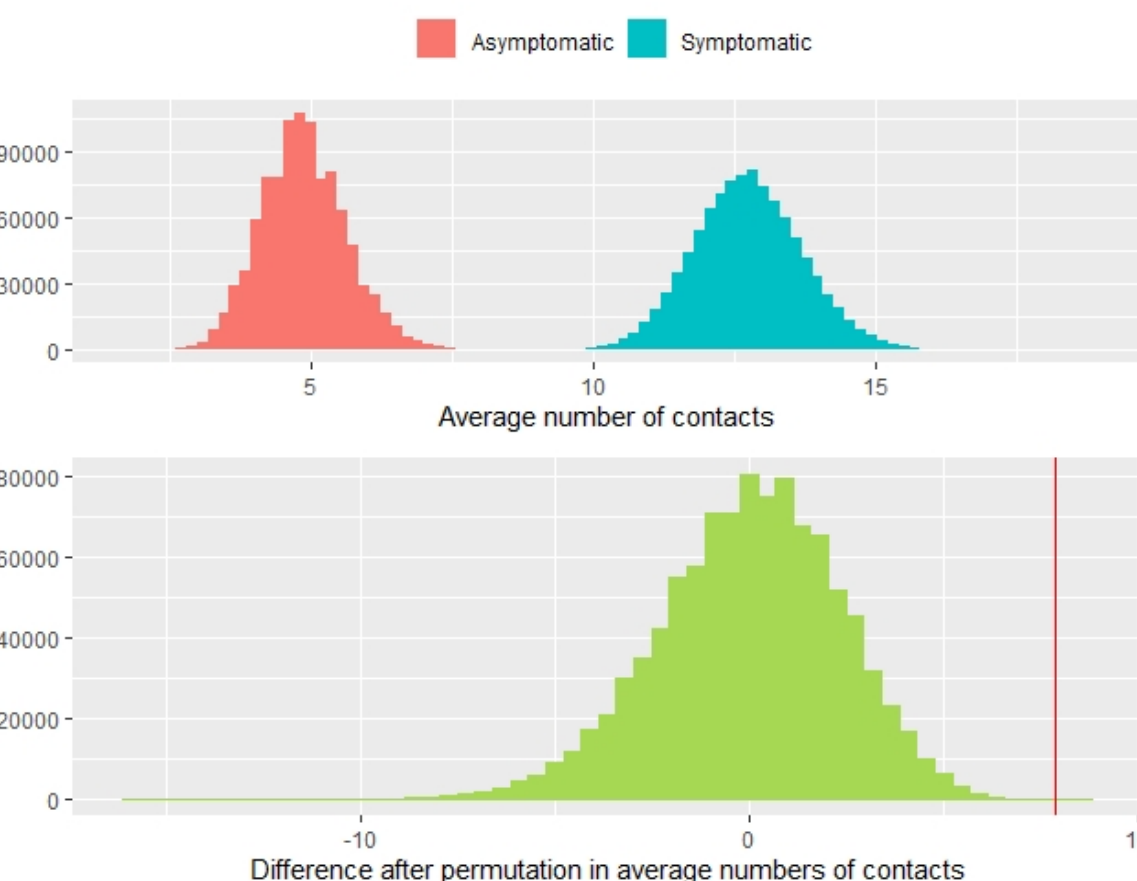
Figure 2. The histograms of the average numbers of contacts by the symptomatic and asymptomatic cases (top panel) and the difference after the permutation in the average numbers of contacts by the symptomatic and asymptomatic cases in the permutation test (bottom panel). The red vertical line indicates the observed difference in the average number of contacts between symptomatic and asymptomatic cases, which lies at the far end of the null